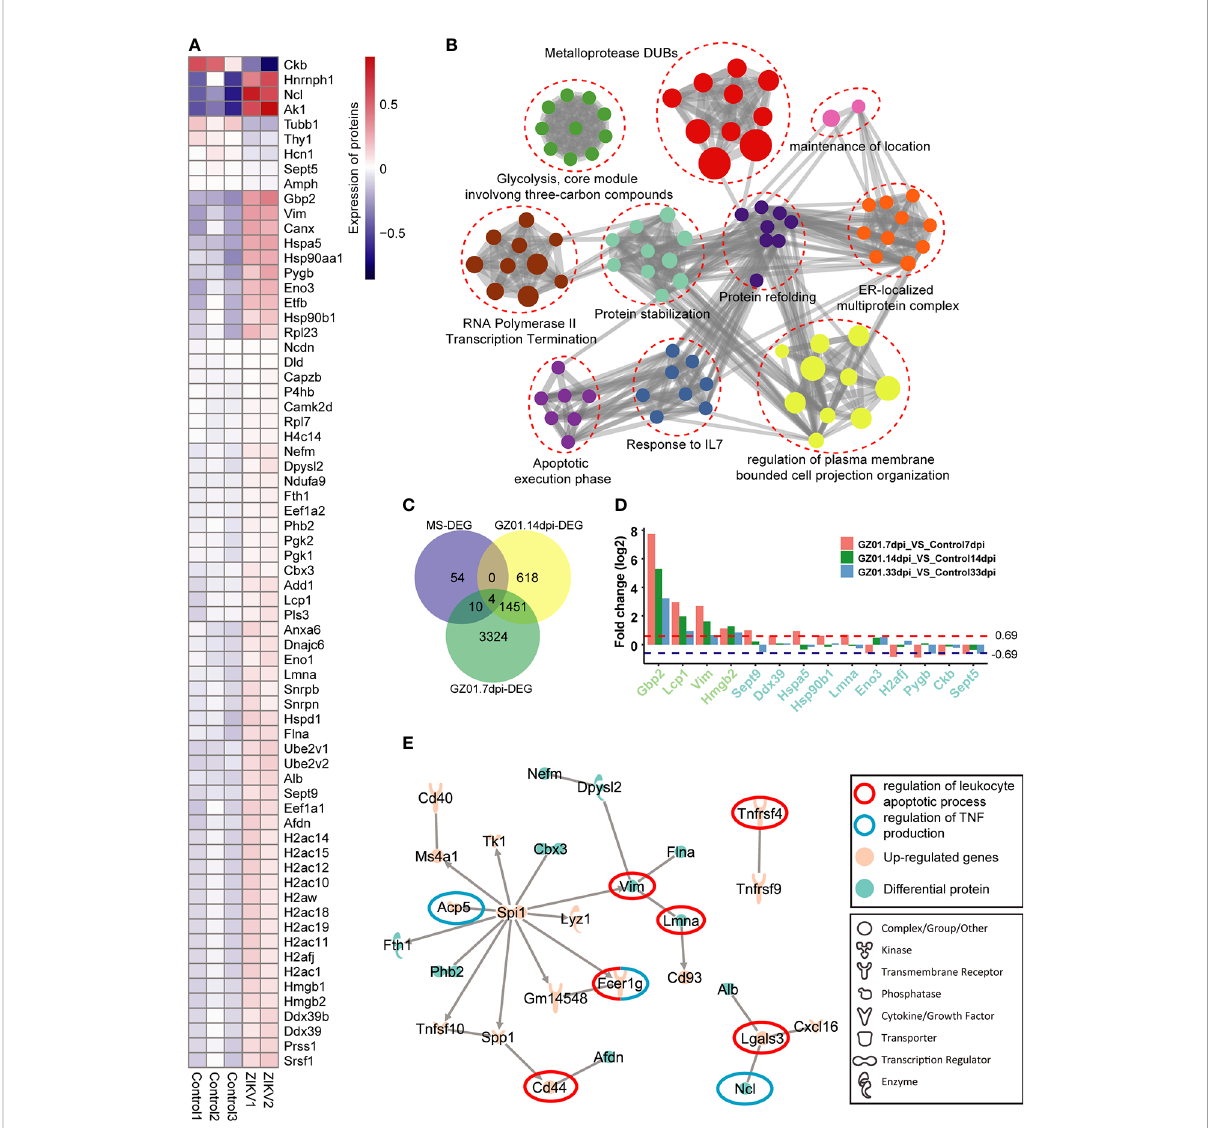
FIGURE 6 Proteomics pro fi les of mice infected with GZ01 at 14 dpi. (A) , Differentially expressed proteins in GZ01 infection mice relative to Control. (B) , Network of enriched terms of differential proteins, colored by cluster ID, where nodes that share the same cluster ID are typically close to each other. (C) , The overlapping gene numbers between DEGs of proteomics and DEGs of transcriptome. (D) , Fold change of the overlapping genes between mice infected with ZIKV and control. The lime-green label indicates the four overlapping genes between proteomic data and transcriptional data at 14 dpi. The cyan label indicates the ten overlap genes between proteomic data and transcriptional data at 7 dpi. (E) , Regulatory network between differential proteins and the upregulated genes in transcriptome